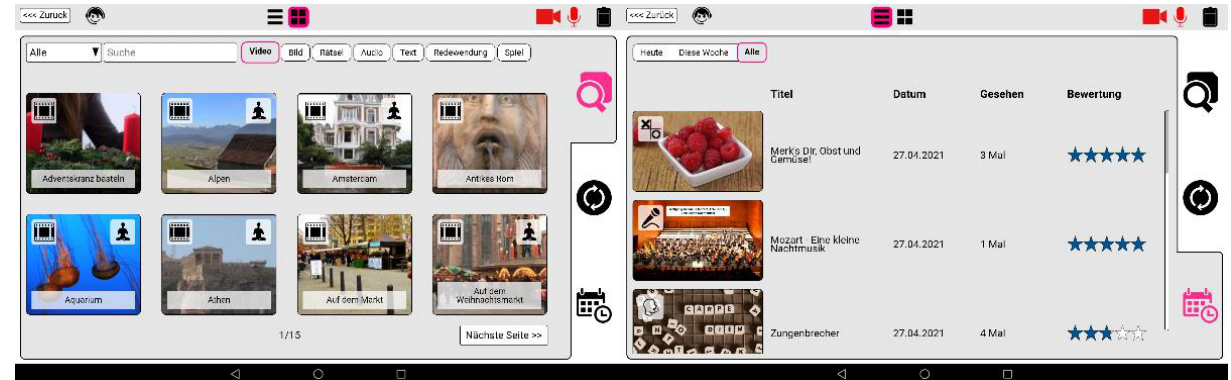
Figure 2. I-CARE Activation Contents (left-hand side) and ratings (right-hand